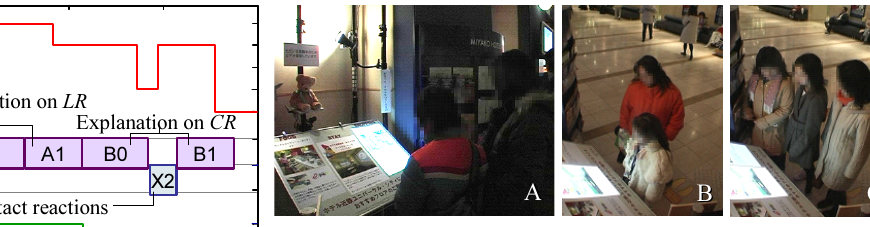
Figure 10. Demonstration Experiment in Lobby of